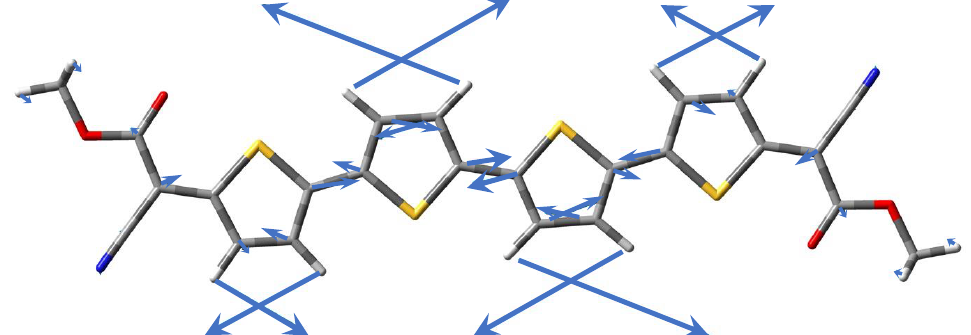
Figure 9. Vibrational mode of EsQ4 computed at 1046 cm − 1 , assigned to the observed peak at ca. 1100 cm − 1 and displaying the largest HR factor among low frequency vibrations.